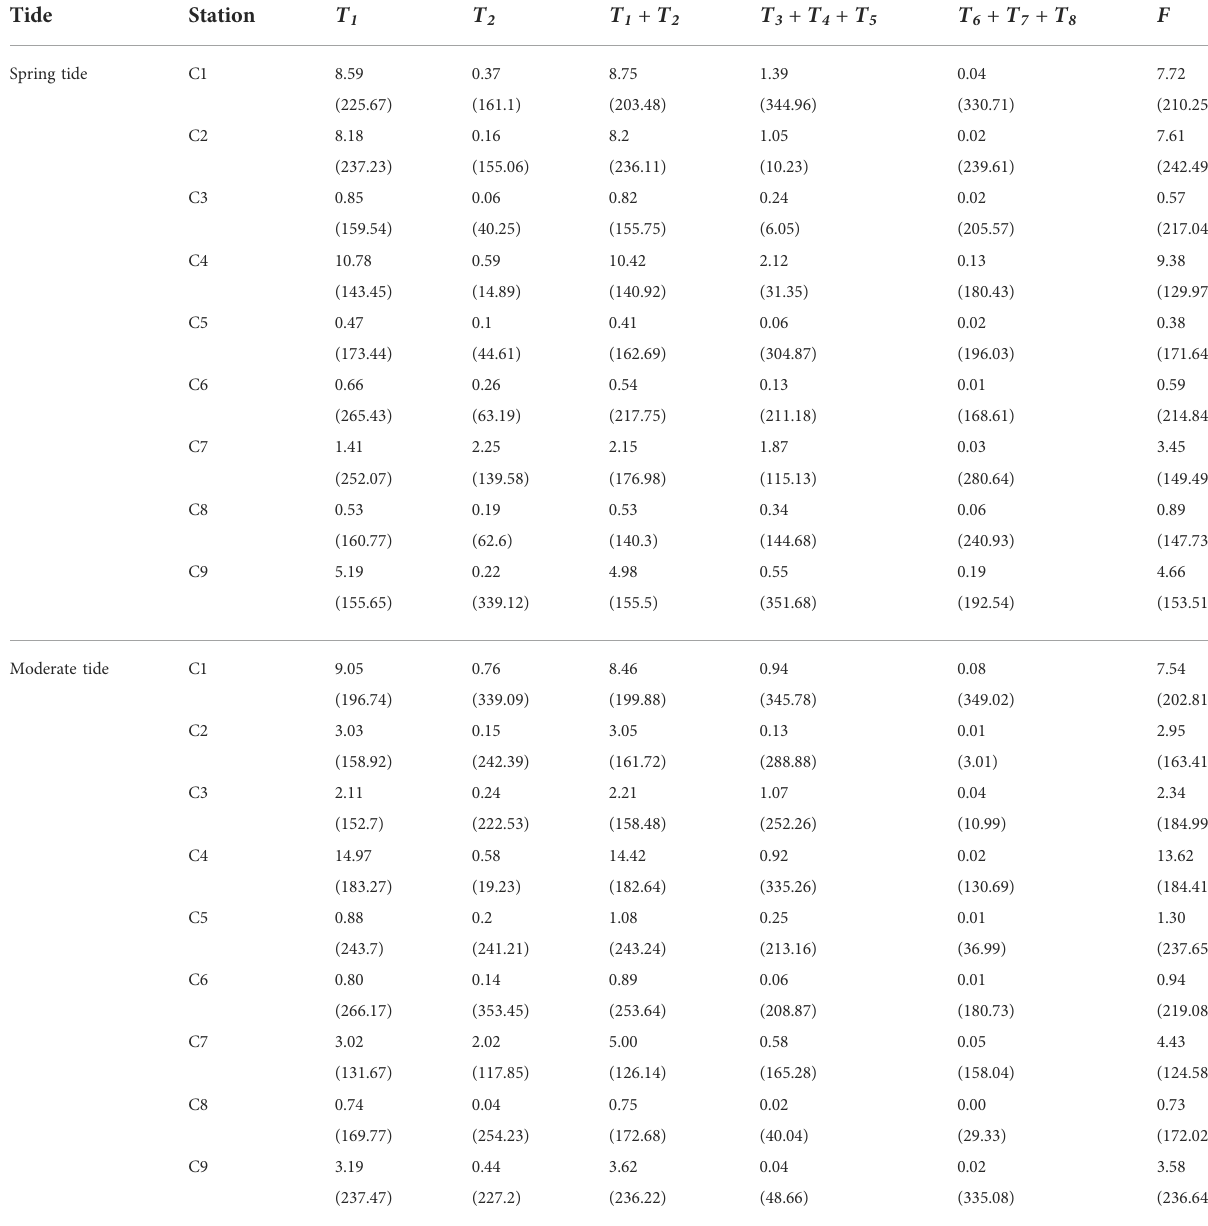
TABLE 2 The sediment transport fl ux at various stations during the spring and moderate tides (items without parentheses aresediment transport fl ux (g · s − 1 · m − 1 ), and items in parentheses are suspended sediment transport direction (degrees)). Tide